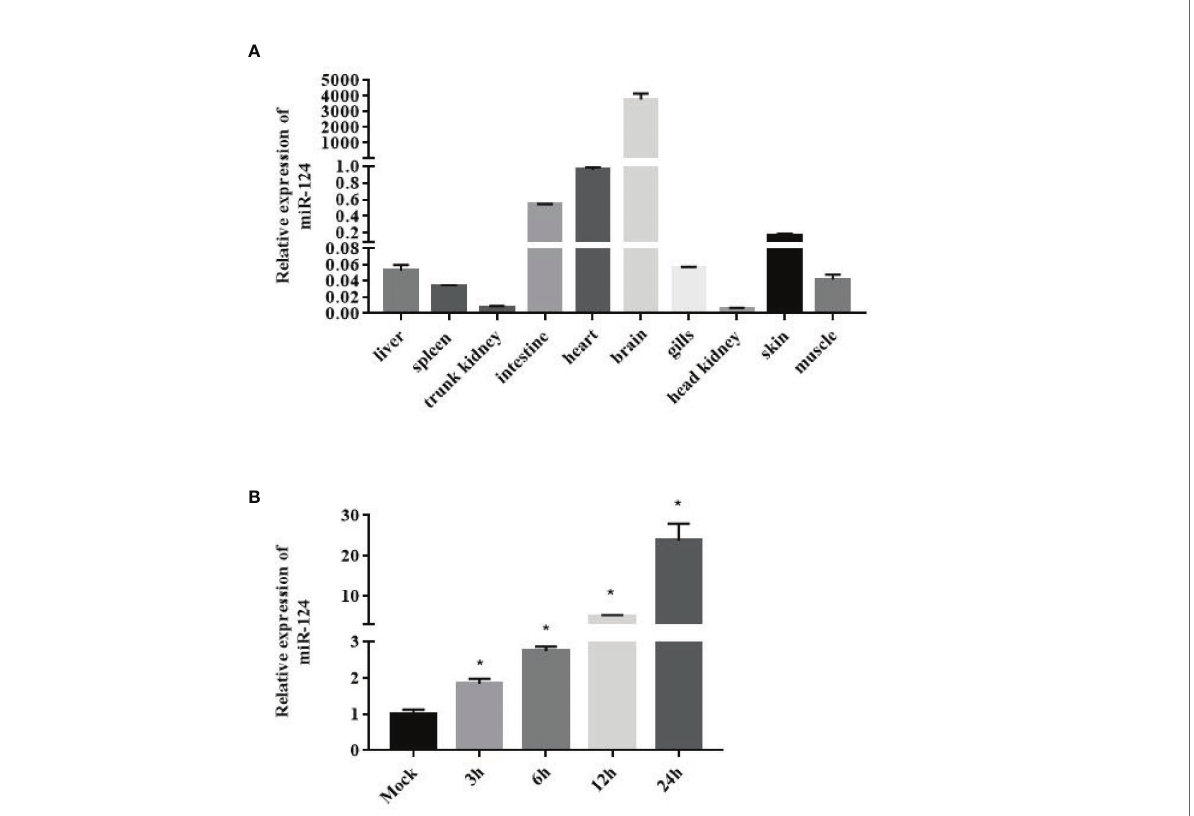
FIGURE 1 | Expression of miR-124 in tissues and in response to Singapore grouper iridovirus (SGIV) infection in the GS cell. (A) Expression of miR-124 was detected in the 10 tissues. Data are presented as mean ± SD, N = 3. (B) Expression of miR-124 in response to SGIV infection in the GS cell. The GS cells were incubated in 24-well plates and after 24 h were infected by SGIV. U6 was used as internal reference. The control and SGIV infection groups of the miR-124 expression signi fi cant differences at each time points are indicated with * ( p < 0.05). Data are presented as mean ± SD, N =